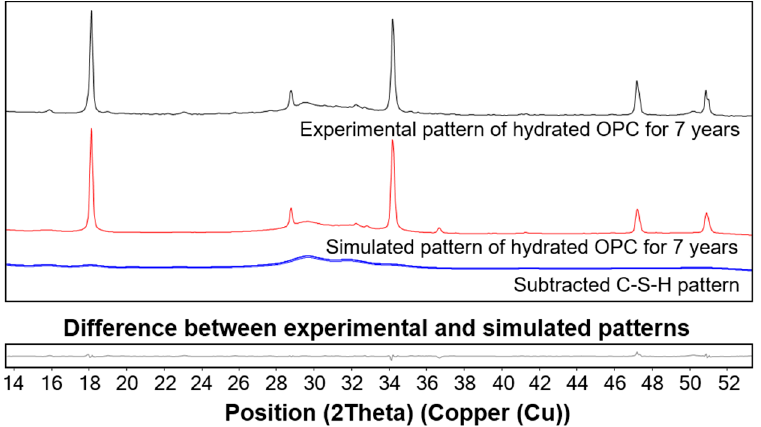
Figure 5. Experimental and simulated diffraction patterns of silica fume .